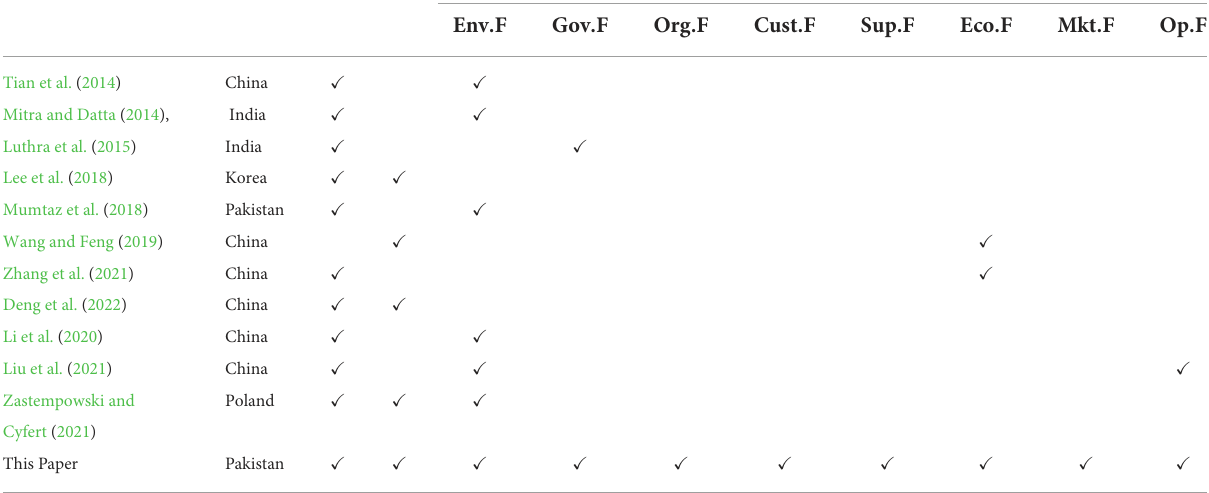
TABLE 1 The characteristics of this